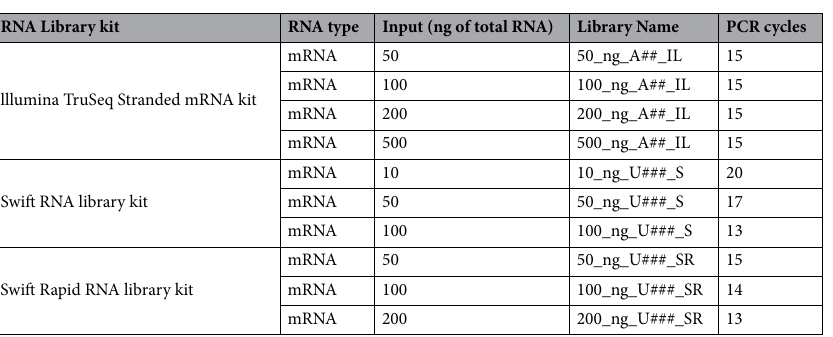
Table 2. Overview of different RNA library preparation kits and conditions analyzed in this study.